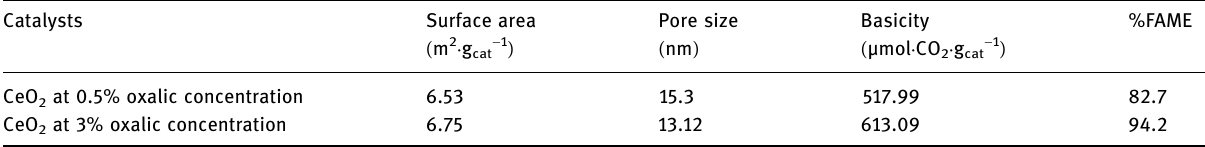
Table 1: Properties of CeO 2 synthesized using 0.5% and 3% oxalic concentrations at 400 rpm stirring rate